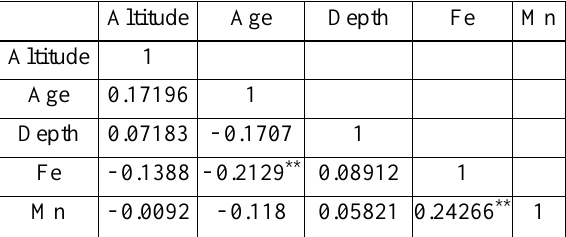
Table 14. Pearson’s correlation coefficient between water source characteristics (summer)